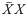
Transition Probabilities.(A) Probability P(X|nX) to change the unknown positions of the code from any color (R, B or Y) to a given color X (R, B or Y) as a function of nX, this is, the number of nearest neighbors already with color X. Results for each color are represented by the corresponding colored symbols. (B) Probabilities P(Xf|Xi; nXf) for the unknown positions of the code as a function of nXf. Open and solid symbols represent, for a given position, transitions between different colors (X¯X) and between the same color (XX) respectively. Results for each color are represented by the corresponding colored symbols. Dashed lines represent fitting Eq (5) to the data (see Section Bayesian update for more details).